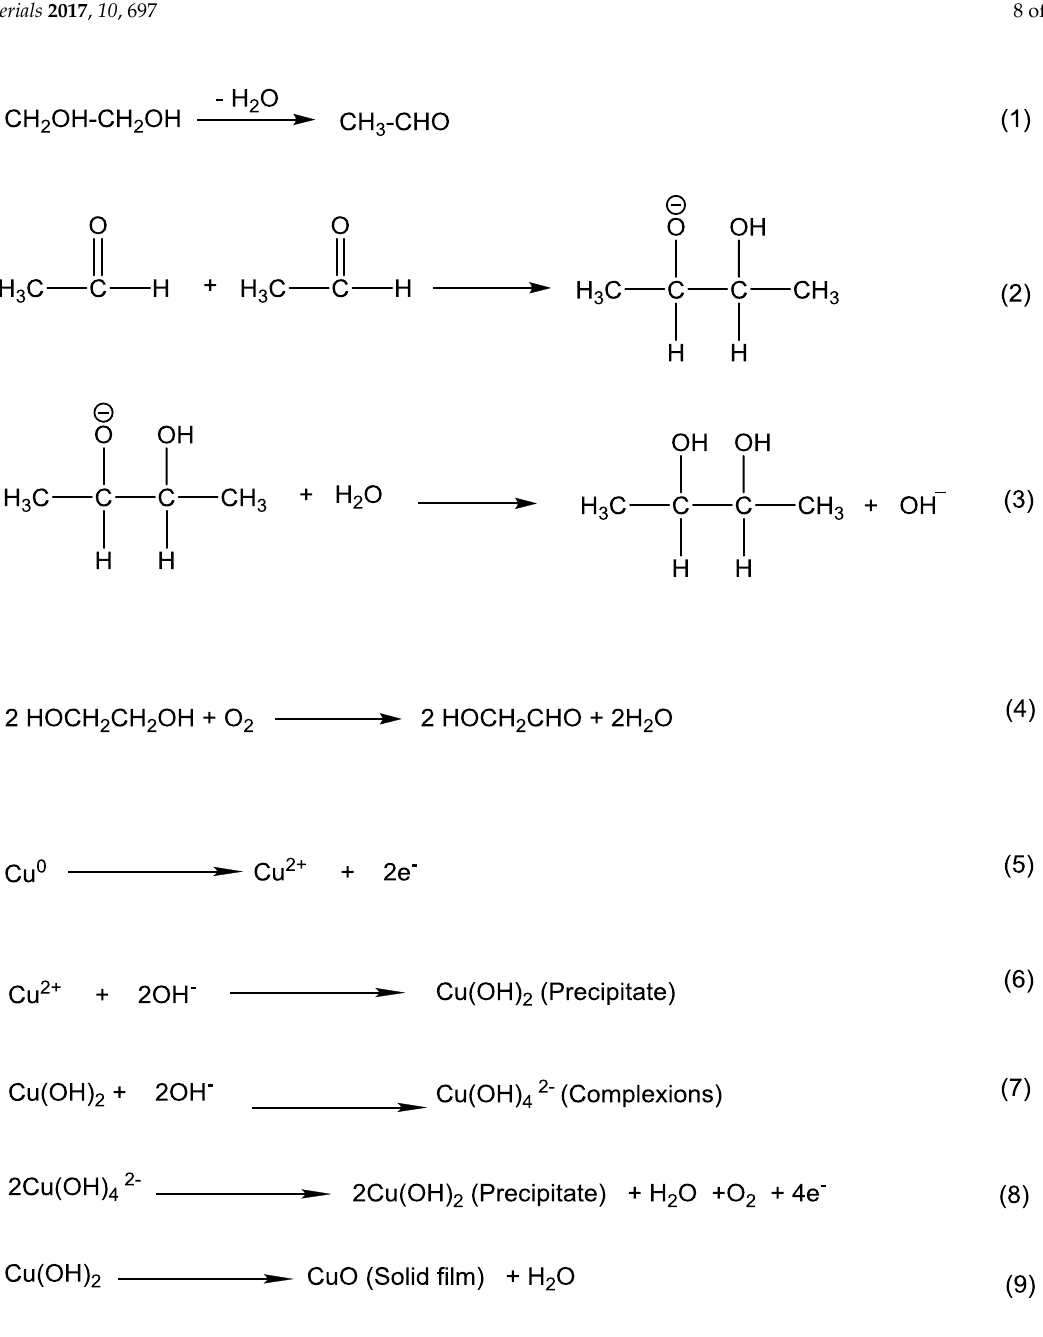
Figure 5. The proposed mechanism of CuO formation.